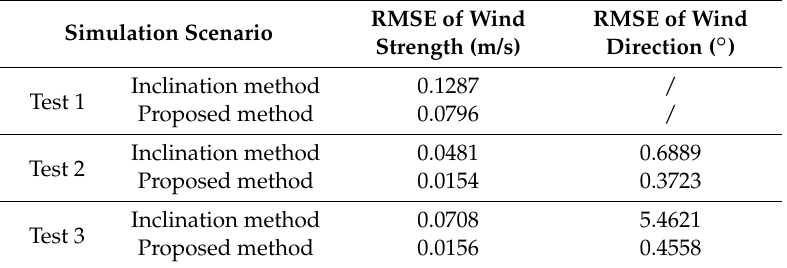
Table 3. RMSEs of the estimated wind